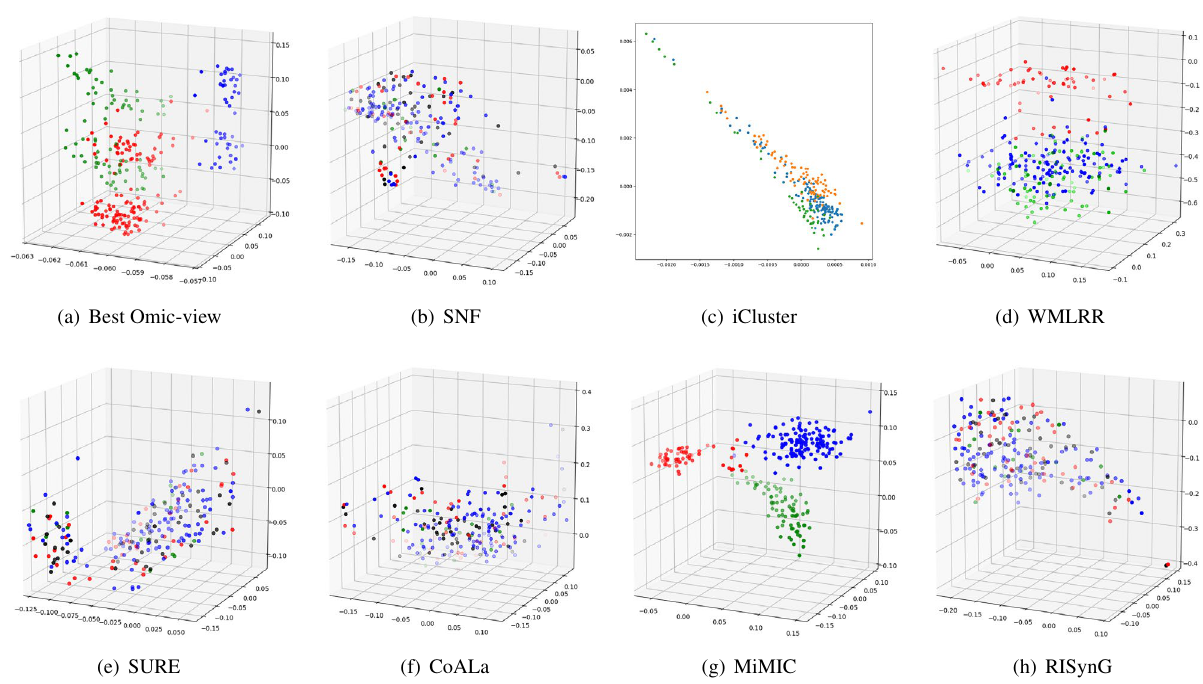
Figure 6. Comparative analysis of different integrative sub-spaces for LGG